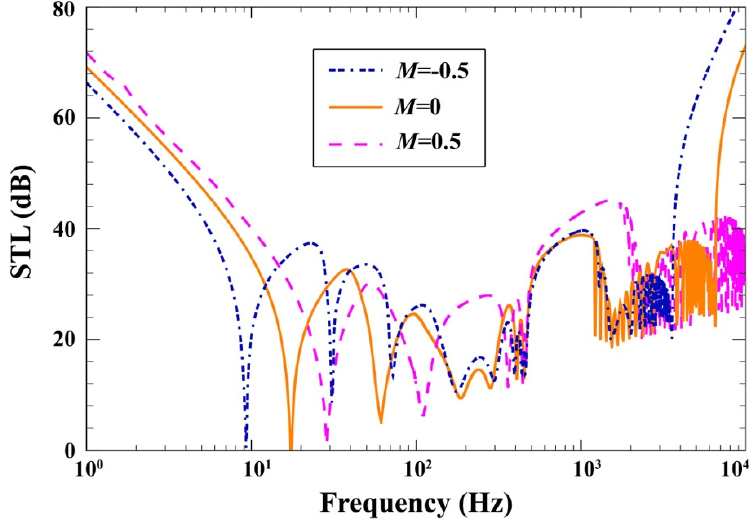
Figure 7. Effect of the external flow Mach number on the changes of STL.